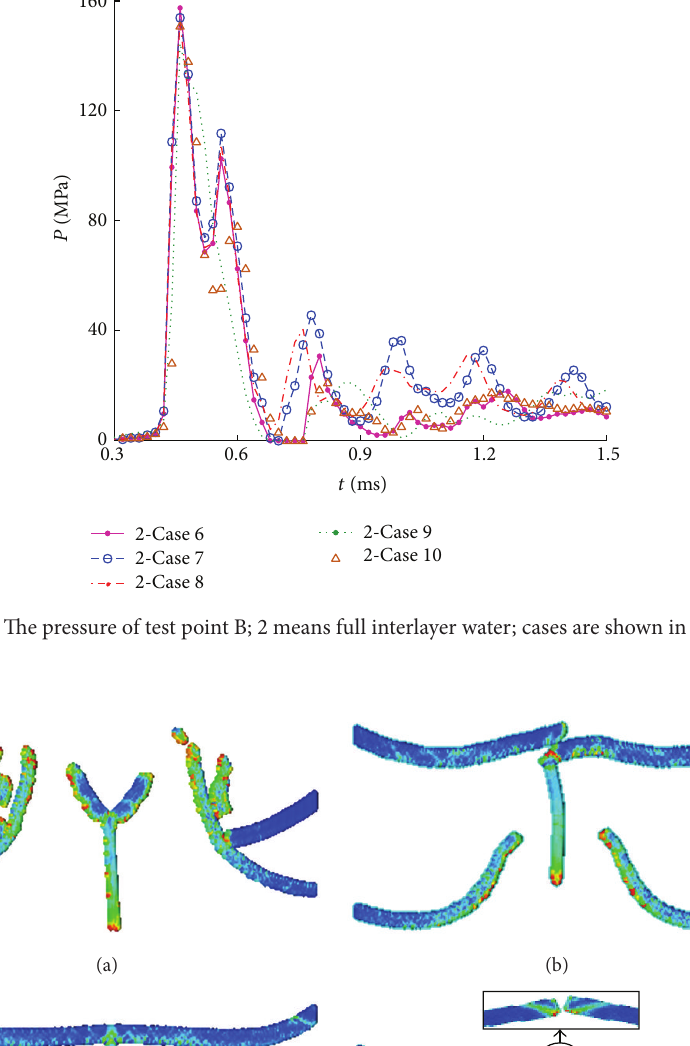
will better protect the inner shell and the interlayer water can reduce the damage caused by